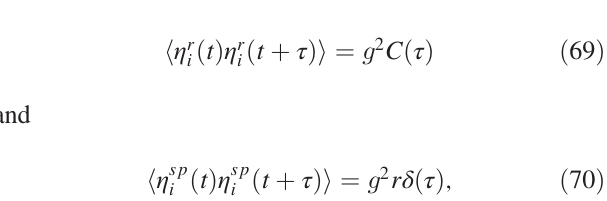
FIG. 11. Network of spiking neurons with inhomogeneous Poisson statistics. Simulation results for a network that follows the dynamic equation in Eq. (65). (a) Above the critical point ffiffiffi p 2 of the underlying rate dynamics, g , the rate term domi- c ¼ nates the DMF equation, Eq. (72), and the autocorrelation 30 , solid line) is fully ex- calculated from simulation ( r τ s ¼ plained by autocorrelations of the rates, found by Eq. (45) (dashed line). (b) For values of g well below the rate transition, the rates do not have intrinsic fluctuations, and the fluctuations in the fields are solely due to the Poisson firing. MFT results of 30 , solid Eq. (74) (dashed line) agree with simulations ( r τ s ¼ line). In intermediate values of g , rate and spike fluctuations interact nonlinearly. (c) Normalized variance of the local fields q ð ∞ Þ from simulations of networks at different gain levels in the transition region. For higher levels of r τ , the crossover between s variance dominated by the Poisson process and variance domi- nated by the fields dynamics becomes sharper. (d) The coefficient of variation ( CV ), Eq. (76), for different values of gain. For low values of g , the CV approaches 1, indicating a Poisson process with (almost) constant rates. For higher values of the gain, the CV is larger, as expected from an inhomogeneous Poisson process. The crossover between the two regimes becomes sharper as r τ s increases. Simulations are performed using an inhibitory population with Gaussian-distributed connectivity ( N ¼ 3500 , K ¼ 700 ) and ¯ g ¼ h 0 ¼ 1